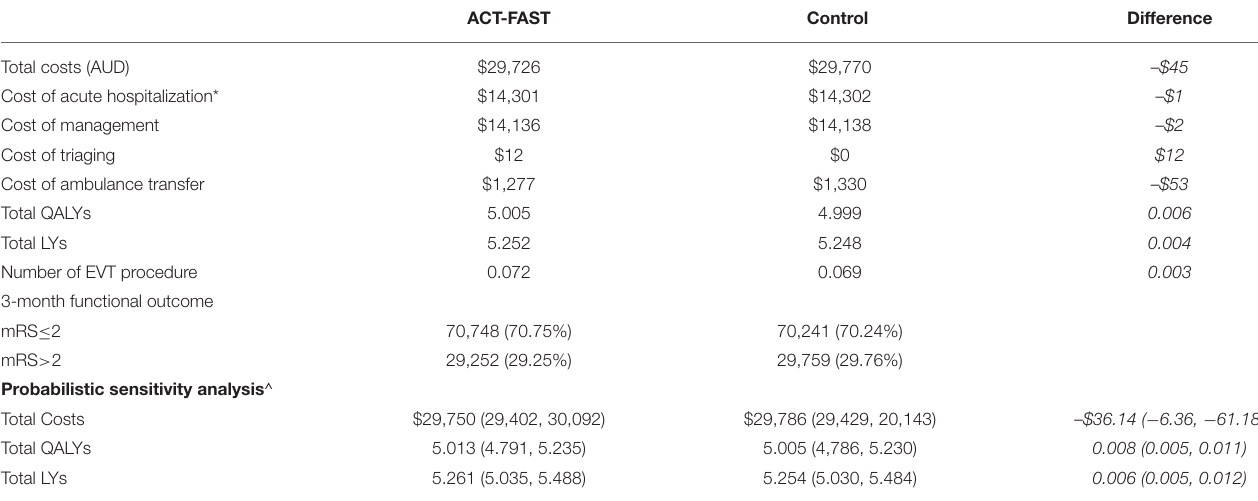
TABLE 3 | Results of base case cost-effectiveness analysis.